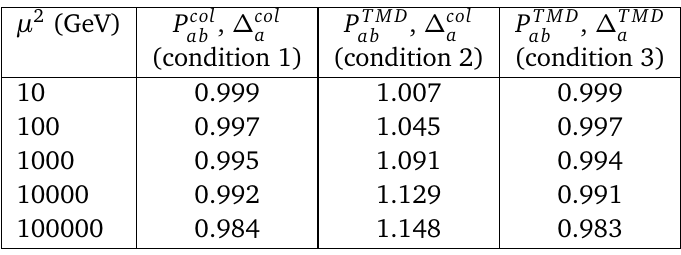
Table 1: Check of momentum conservation: